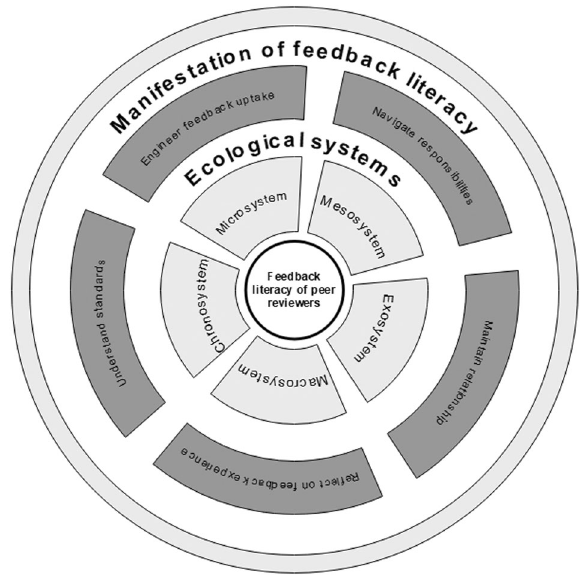
Fig. 1 Conceptual framework of feedback literacy of peer reviewers. The outer ring of the fi gure shows the components of feedback literacy while the inner ring concerns the layers of contexts (ecosystems) which in fl uence the manifestation of feedback literacy of peer